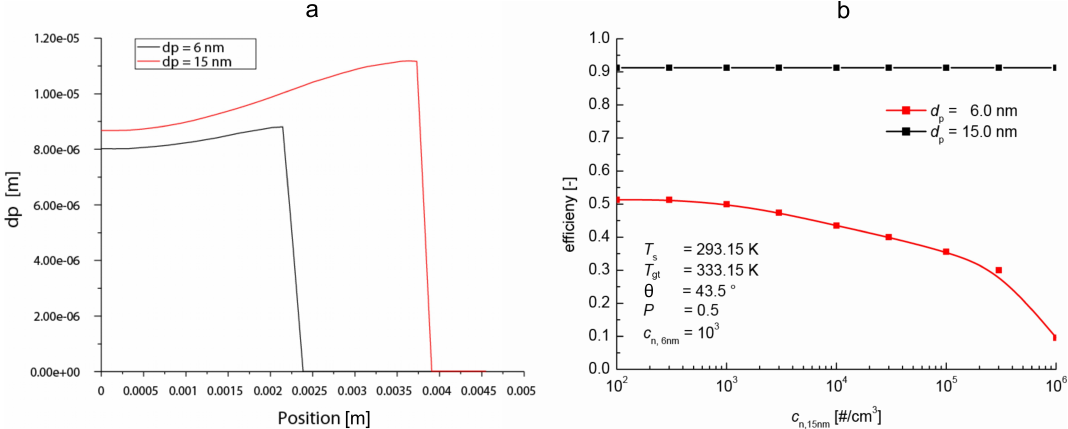
Fig. 5. Radial distribution of particle size at the growth tube outlet (a) and CPC counting efficiency as function of inlet particle number concentration (b) in a bi-modal modelling